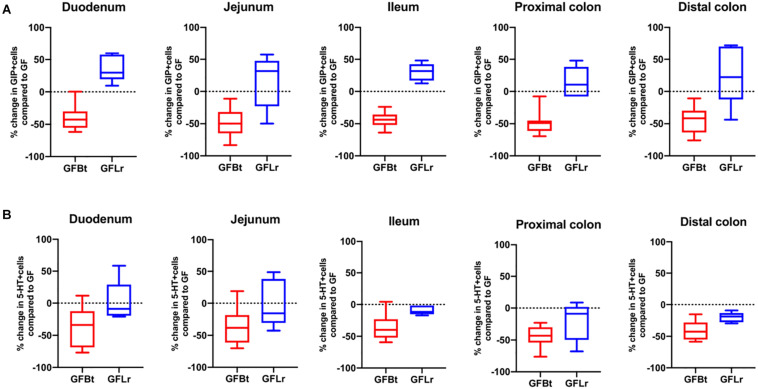
The effect of Bt on GIP and 5-HT EECs is not replicated with another gut commensal bacterium. (A) Percentage change of GIP+
(A) or 5-HT+
(B) EECs throughout the GIT of germfree mice after mono-colonization with Bt (GFBt, n=10) or Lactobaccillus reuteri (GFLr, n=5) compared to the number of GIP+ cells in GF (n=11) mice, which is shown as a dashed horizontal line and is set at zero. The box of the box whisker plots extends from the 25th to 75th percentiles with the horizontal line within the box representing the median and the whiskers representing the minimum and maximum values.